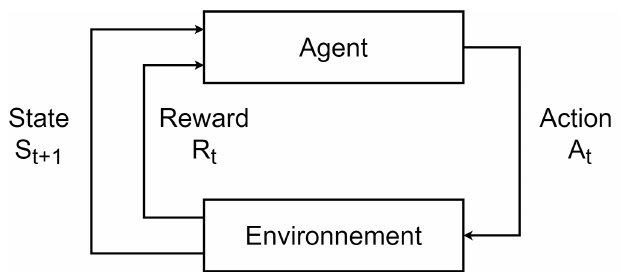
Figure 3. A Markov decision